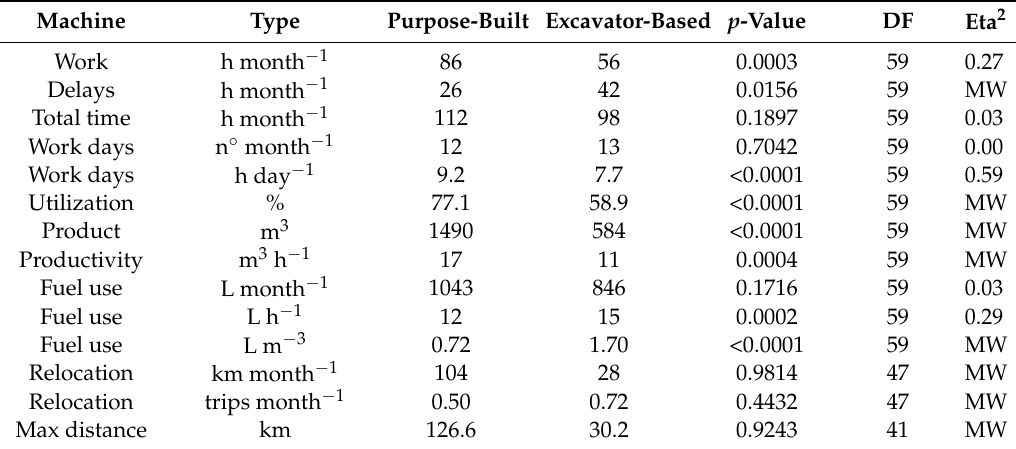
Table 4. Means of the monthly totals by machine